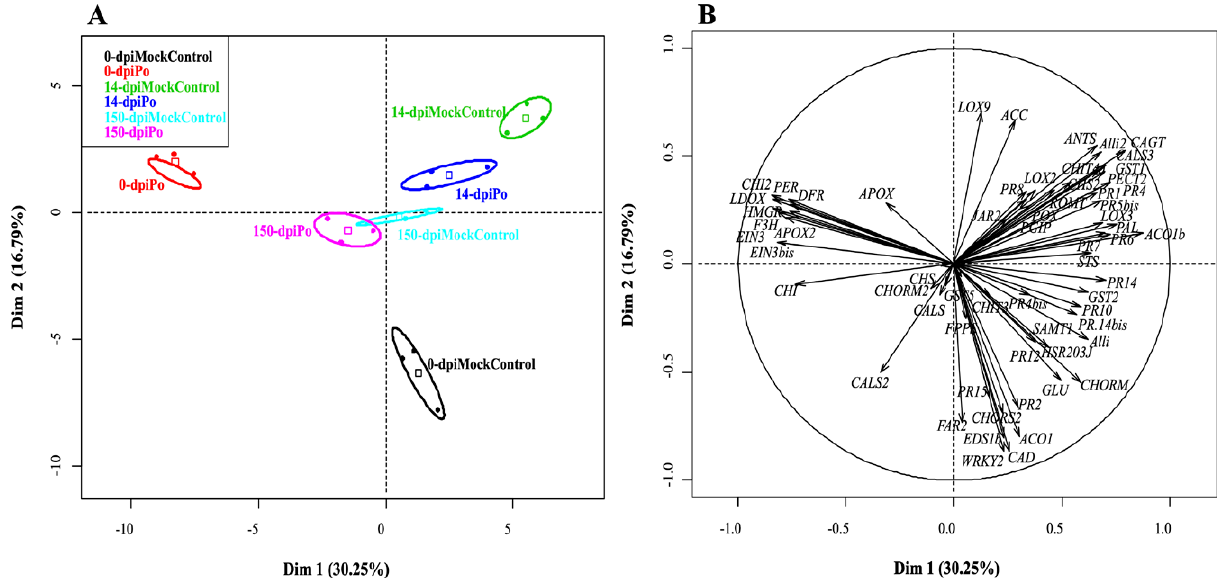
Figure 3. A. Principal component analysis of specific grapevine responses to Pythium oligandrum and mock-control treatments (relative expression levels of the 62 genes involved in plant defences) at 0, 14 or 150 d after treatments applied at trunk level. Gene expression of control plants was used as the reference to calculate relative expression. Ellipsoids represent the centres of factors with 95% confidence. The different groups are indicated by different colours. Po = P. oligandrum . B. Distribution into the correlation circles of the relative expression levels of the 62 genes